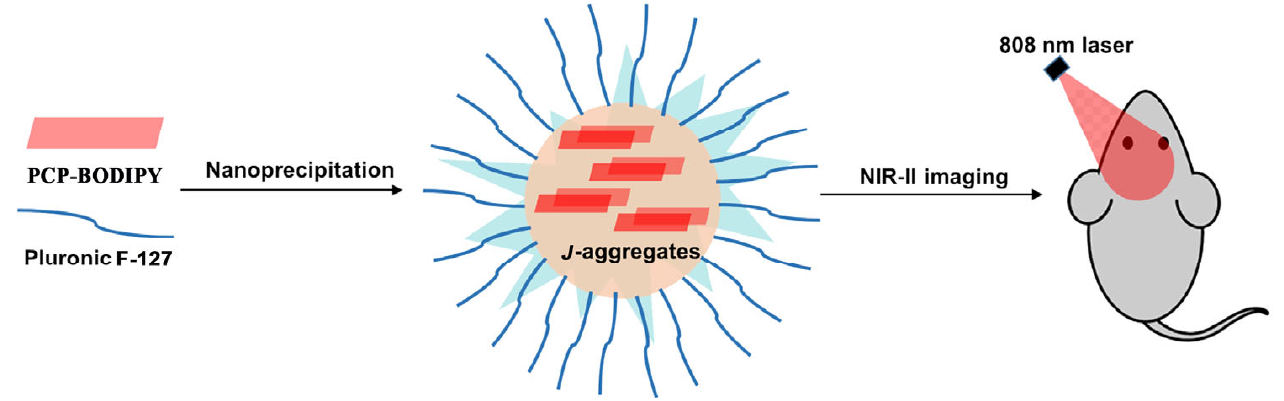
Figure 2. The NIR ‐ II imaging of PCP ‐ BODIPY in nanoparticles (NPs). Figure 2. The NIR-II imaging of PCP-BODIPY in nanoparticles